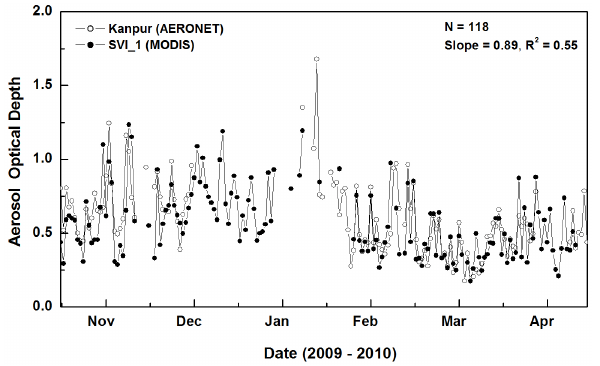
Fig. 12. Comparison of temporal variation of daily mean MODIS aerosol optical depth (AOD) at Surya Village (SVI 1) and AERONET measured column AOD at neighbouring urban centre (130km away from SVI 1), Kanpur.